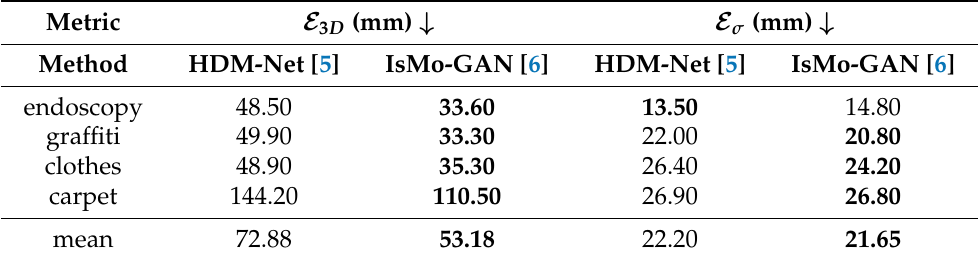
Table 5. Comparison of different point cloud reconstruction methods using the synthetic thin plate dataset [5] under one illumination. Bold values show the best results for each metric.